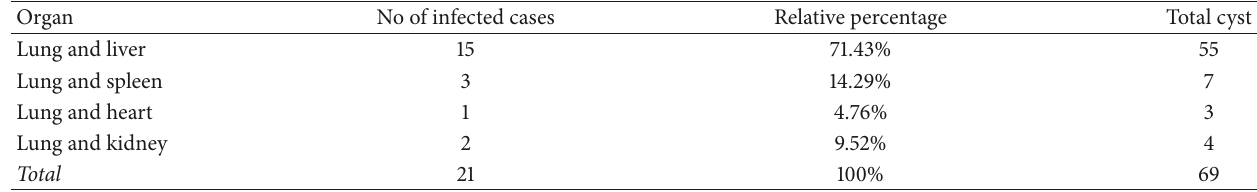
Table 2: Multiple organ infection of hydatidosis from sample taken at Hawassa municipal abattoir.